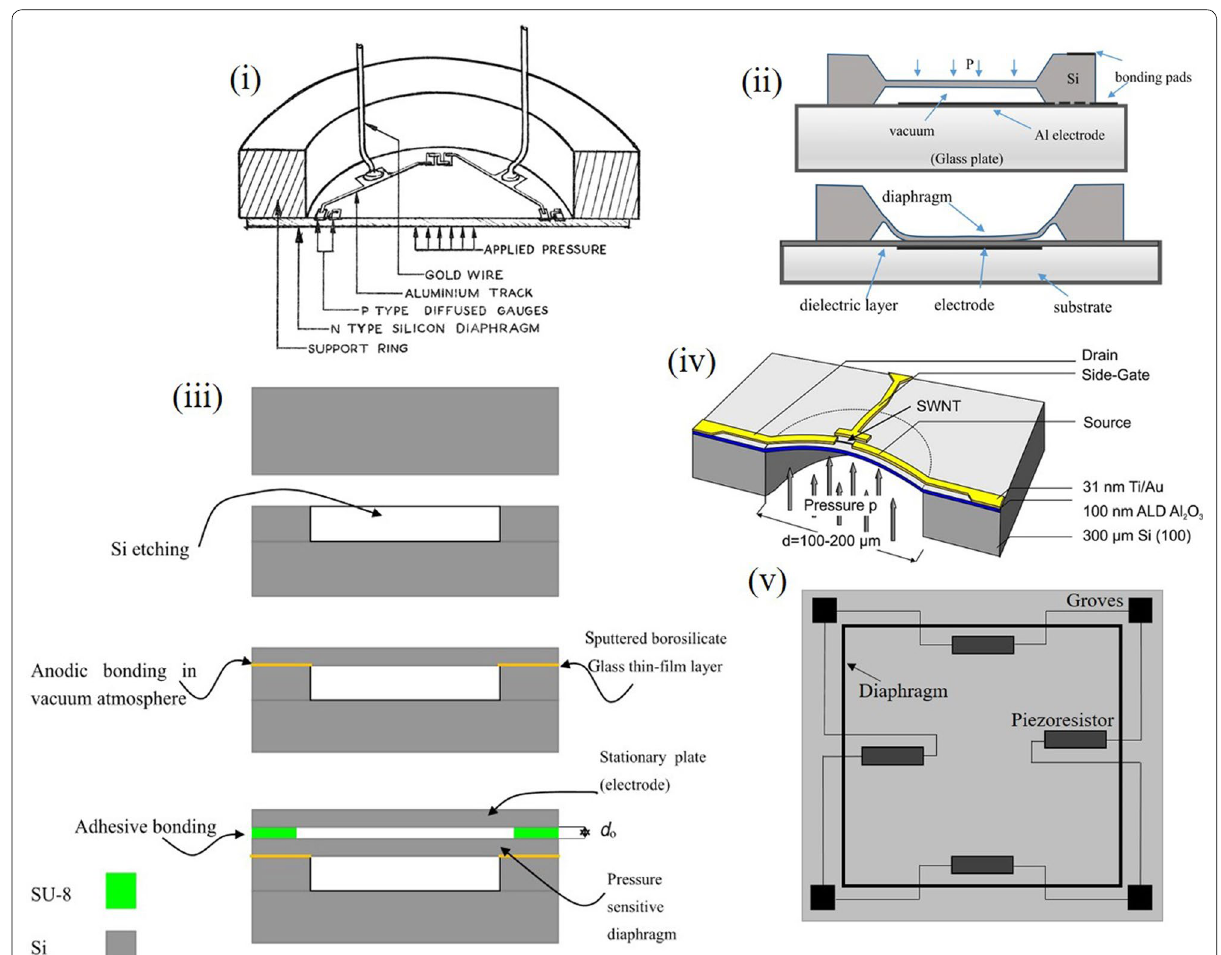
Fig. 2 Early silicon based pressure sensor fabricated with MEMS (i) Complete Si wafer based crude design (Reproduced with permission from [7] Copyright 2007, Emerald Publishing Limited ) (ii) Etched Si diaphragm (Reproduced with permission from [8] Copyright 2016, Copernicus Publications ) (iii) SU-8 supported diaphragm (Reproduced with permission from [8] Copyright 2016, Copernicus Publications ) (iv) Carbon Nanotube (CNT) strain gauge based peizoresistive sensor diaphragm (Reproduced with permission from [182] Copyright 2006, American Chemical Society ) (v) S shaped diaphragm with piezoresistive material at the groves for improved